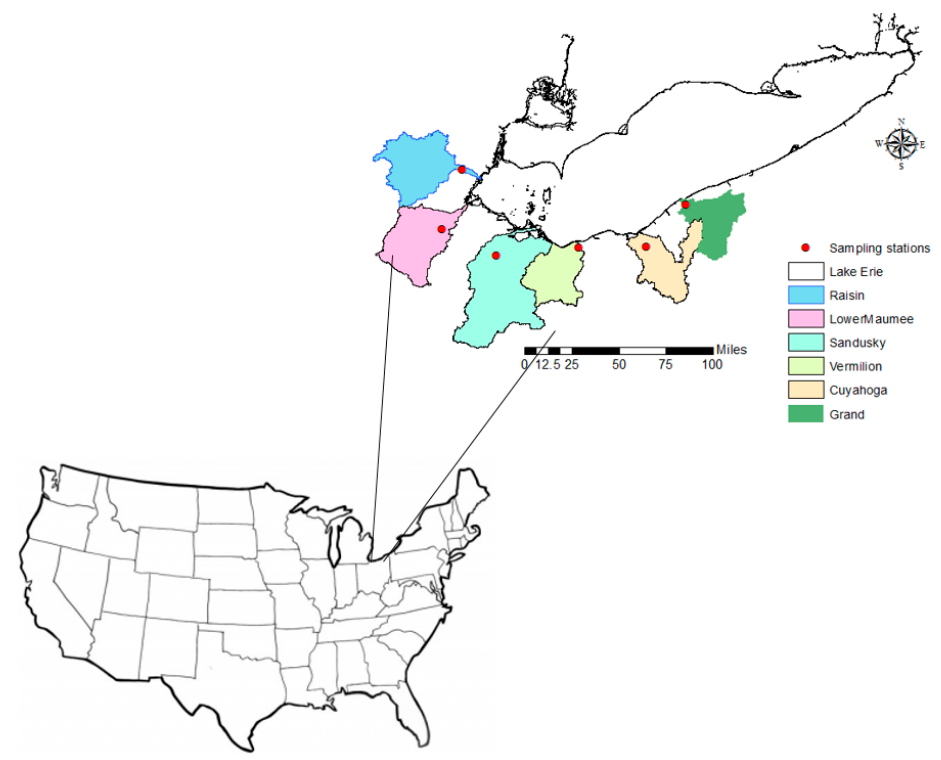
Figure 1. The locations of the sampling stations in Cuyahoga, Grand, Maumee, Vermilion, Raisin, and Sandusky watersheds.